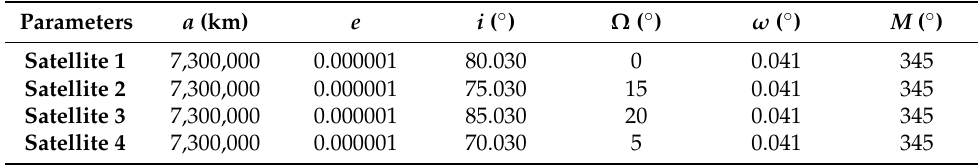
Table 1. The initial orbital parameters of the satellites. Parameters